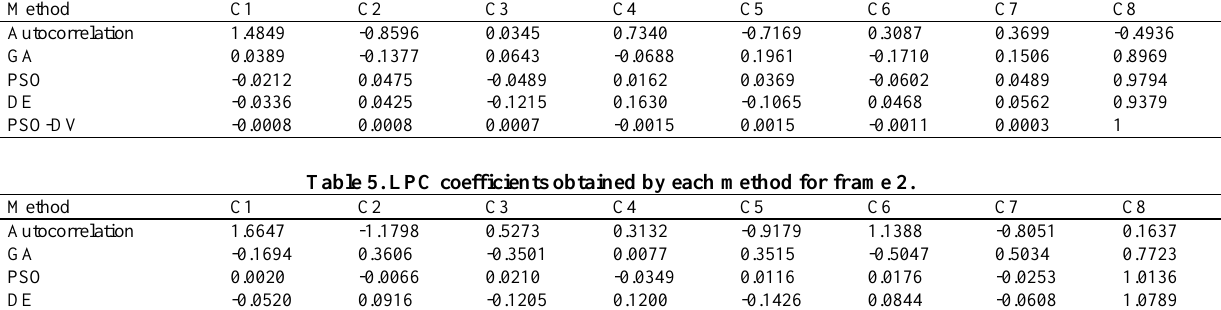
Table 4. LPC coefficients obtained by each method for frame 1. Method